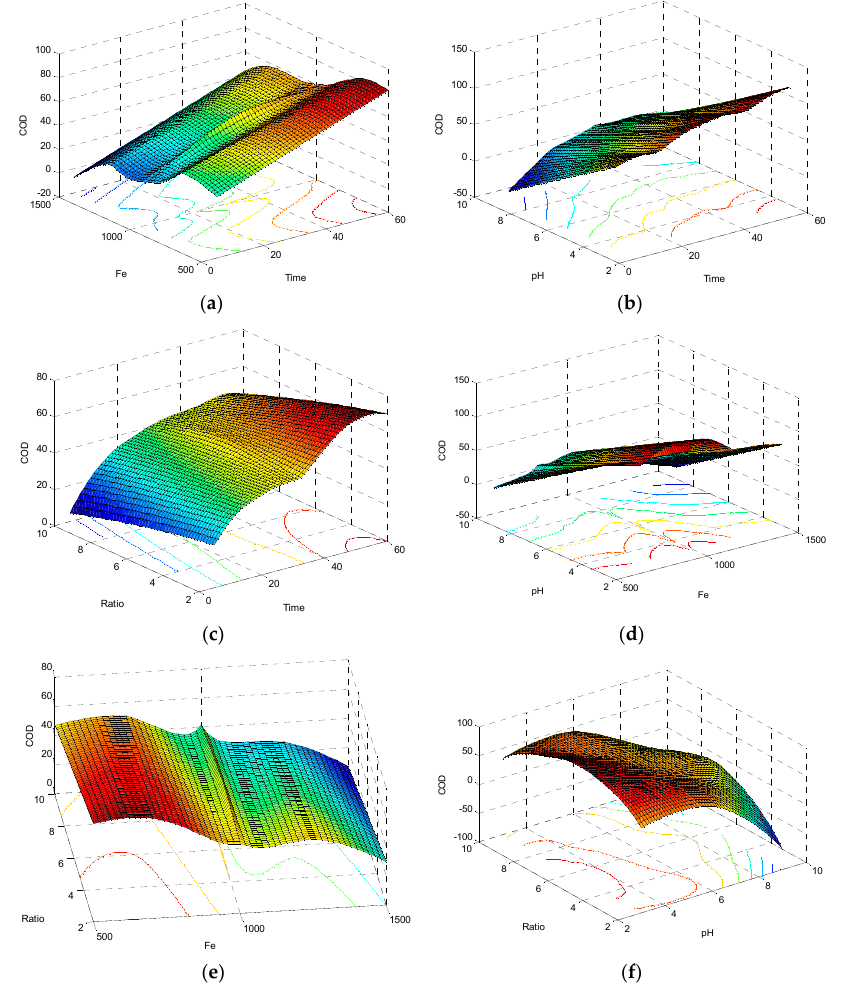
Figure 4. ( a ) 3D-response surfaces for COD reduction as a function of contact time and Fe 2+ concentration; ( b ) contact time and pH; ( c ) contact time and H 2 O 2 :Fe 2+ ratio; ( d ) Fe 2+ concentration and pH; ( e ) Fe 2+ concentration and H 2 O 2 :Fe 2+ ratio; and ( f ) pH and H 2 O 2 :Fe 2+ ratio.